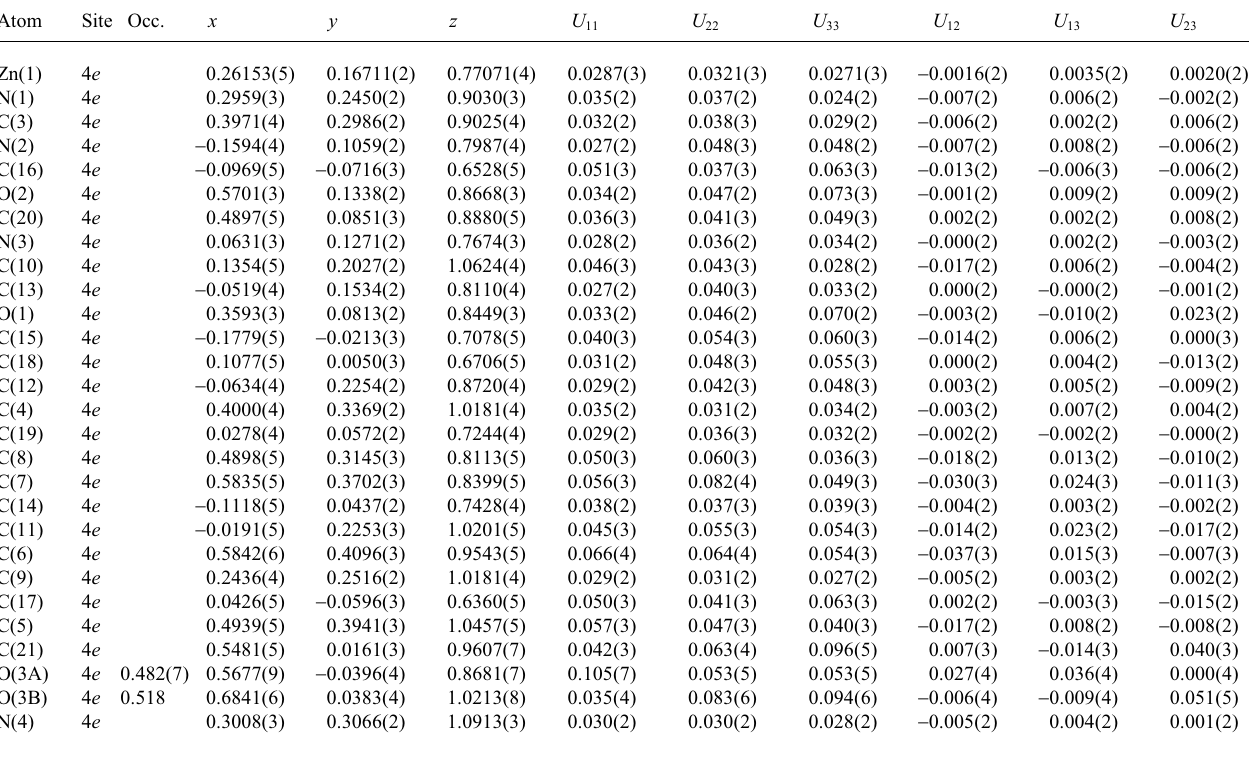
Table 3. Atomic coordinates and displacement parameters (in Å 2 ). Atom Site